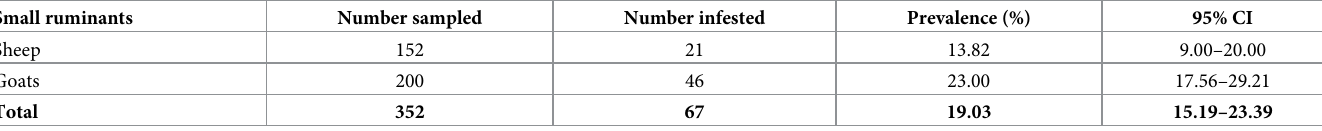
Table 2. Prevalence of tick infestation among small ruminants in Ilorin, Nigeria. Small